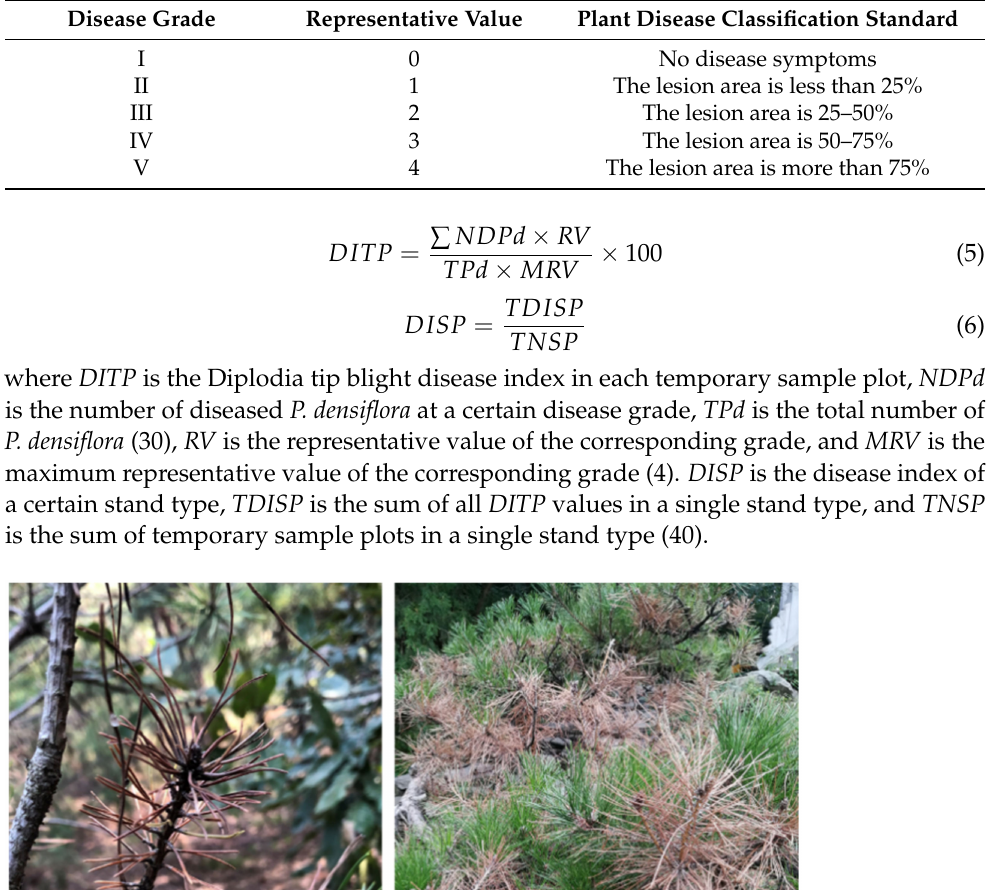
Table 1. Plant disease classification standard of Diplodia tip blight in Pinus dentiflora .